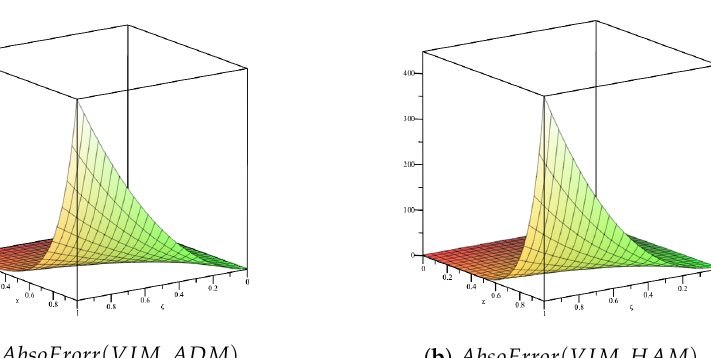
Figure 1. Graphical simulation of the second-level approximate solution ψ 2 ( χ , ζ ) when η = 0.75 and ¯ h = − 1 for Example 1.